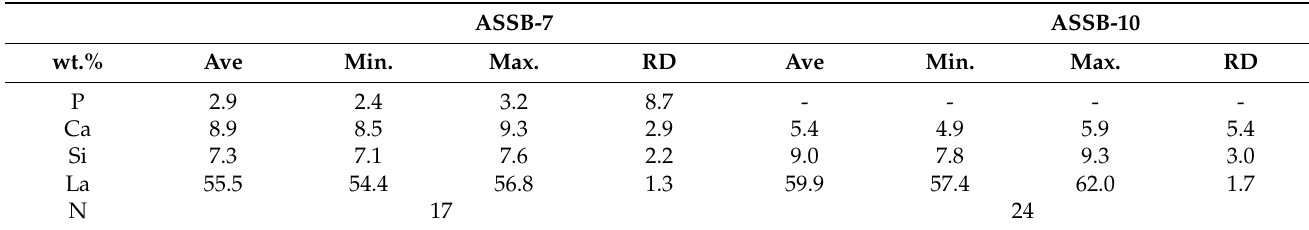
Table A9. Composition of OxS (wt.%) based on single-point analysis. Ave.: arithmetic average; Min./Max.: lowest/highest measured values; RD: relative standard deviation (%);N: number of measurements. ASSB-7 ASSB-10